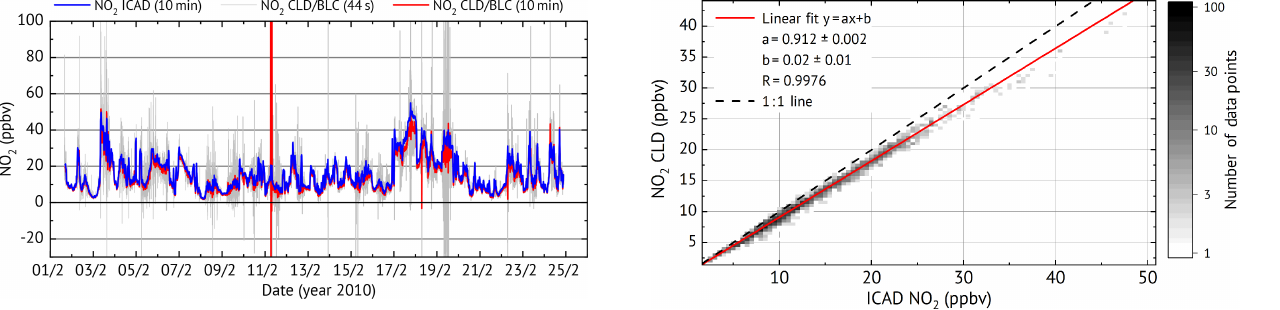
Figure 12. Correlation plot between ICAD NO 2 and CLD–BLC